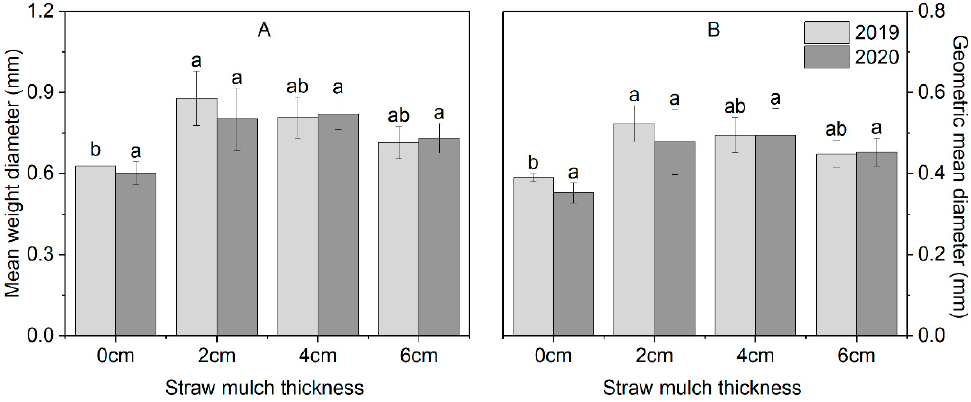
Figure 5. The mean weight diameter (MWD) and the geometric mean diameter (GMD) of soil particles under different mulching treatments. ( A ) represents the mean weight diameter ± standard error of soil particles in the 0 cm, 2 cm, 4 cm and 6 cm straw mulching treatments in 2019 and 2020, and ( B ) represents and the geometric mean diameter ± standard error of soil particles in the 0 cm, 2 cm, 4 cm and 6 cm straw mulching treatments in 2019 and 2020. Different lowercase letters indicate significant differences among different treatments at the p < 0.05 level. n = 3.